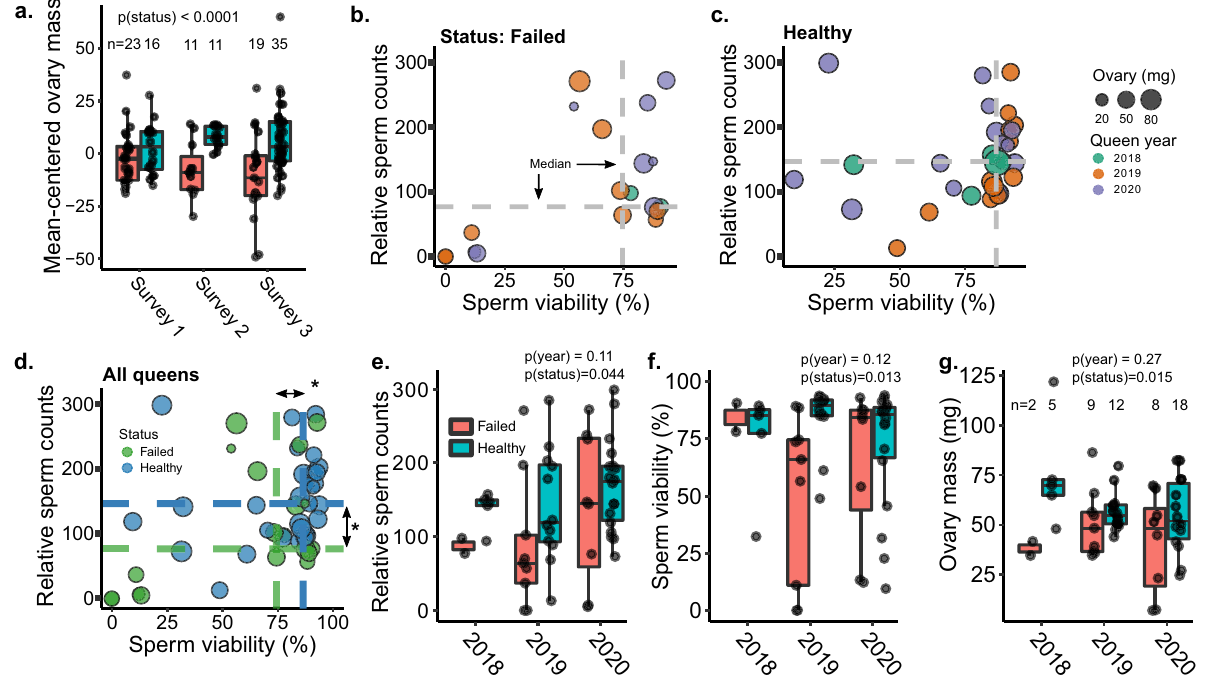
Figure 1. Fertility metrics of failed and healthy queens. In all cases, years indicate the year the queen was reared. ( a ) Ovary masses of failed and healthy queens collected across three different surveys conducted in British Columbia and Pennsylvania (analyzed using a linear mixed model with status as a fixed effect and source location as a random effect). Because the average ovary size differed between surveys, data were mean-centered by survey prior to analysis to better highlight the effect of status. Boxes represent the interquartile range, bars indicate the median, and whiskers span 1.5 times the interquartile range. ( b ) Queens rated as ‘failed’ (spotty brood pattern, drone layer, or dwindling adult population) or ( c ) ‘healthy’ (contiguous worker brood patterns, medium-strong adult population) by local beekeepers in British Columbia were collected in the summer of 2020. Sperm viability and sperm counts were determined by fluorescent imaging, and wet ovary weight was measured on an analytical balance. ( d ) Statistical analyses on data presented in ( b ) and ( c ) were conducted using either a linear mixed model (ovary mass and sperm counts) or a generalized linear mixed model fitted by maximum likelihood (sperm viability; see Table 2 for details). In the statistical models, queen age (0, 1, or 2 years, which corresponds to queens reared in 2020, 2019, and 2018, respectively) and health status (healthy or failed) were included as fixed effects and source location was included as a random effect. Asterisks indicate statistical significance ( p < 0.05), with exact p values given in panels ( e – g ). ( e – g ) Same data as in ( d ) but separated by the year in which the queen was reared (i.e., a 2018 queen was 2 years